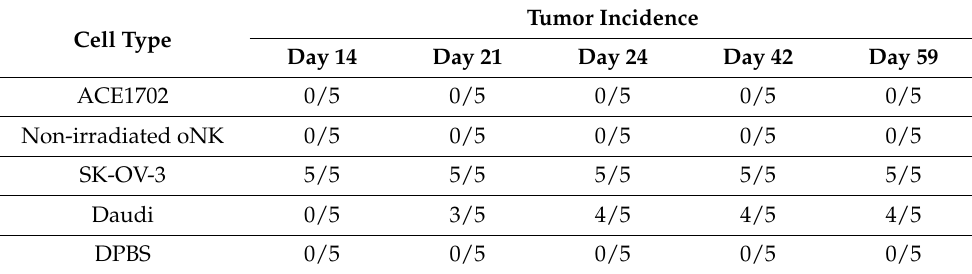
Table 1. Summary of tumor